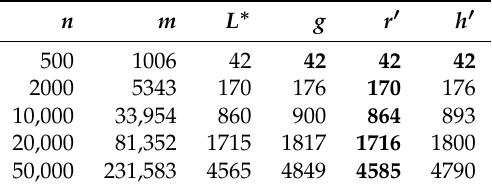
Table 9. Results for Google + Graphs.